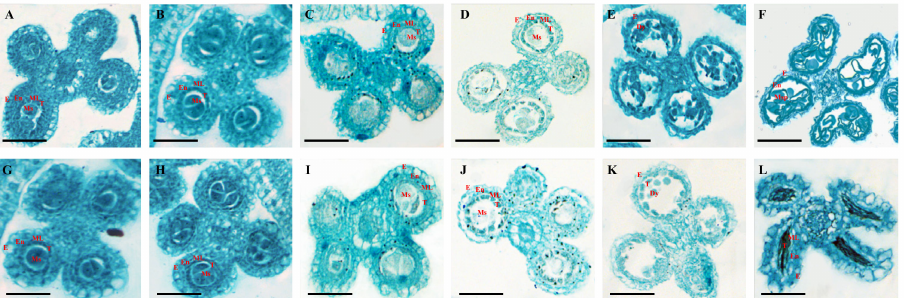
Figure 4. Paraffin sections of anthers of WT and osccr18 mutants at different developmental stages. ( A – F ) Paraffin sections of WT anthers at the developmental stages from S6 to S11. ( G – L ) Paraffin sections of osccr18 anthers at the developmental stages from S6 to S11. E: epidermis; En: endothecium; ML: middle layer; Mp: mature pollen; Ms: microsporocyte; Msp: microspores; T: tapetum; Tds: tetrads. Bar = 30 µ